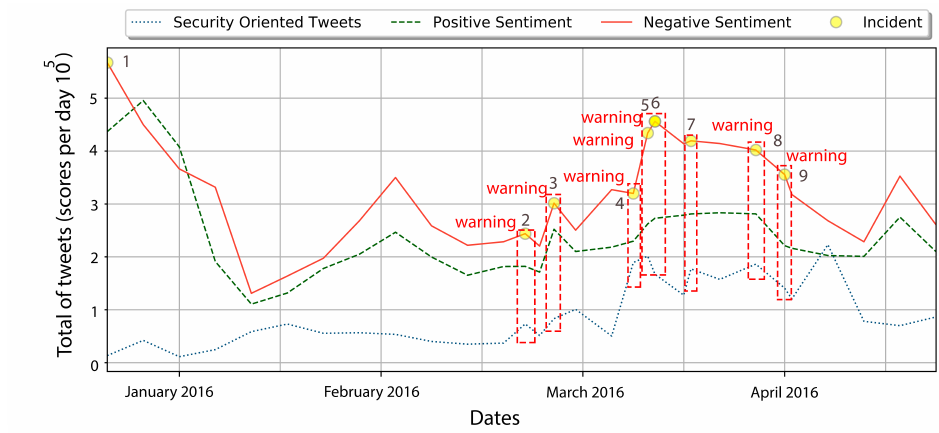
Figure 7. Proposed proof of